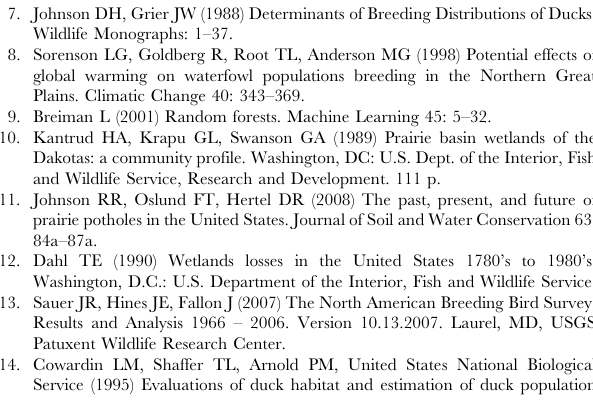
Figure S1 Distribution of grassland and palustrine wetlands on the U.S. Prairie Pothole Region landscape. Darker shades represent greater coverage of grassland (versus cropland) and greater areal coverage of wetlands (log transformed). Figure S2 Map of species distributions for baseline and two future climate projections. Brown indicates areas where the species is predicted to occur and green represents areas where the species is not predicted to occur. Figure S3 Map of species distributions for baseline and two future climate projections. Brown indicates areas where the species is predicted to occur and green represents areas where the species is not predicted to occur. Figure S4 Map of species distributions for baseline and two future climate projections. Brown indicates areas where the species is predicted to occur and green represents areas where the species is not predicted to occur. Figure S5 Map of species distributions for baseline and two future climate projections . Brown indicates areas where the species is predicted to occur and green represents areas where the species is not predicted to occur. Figure S6 Map of species distributions for baseline and two future climate projections. Brown indicates areas where the species is predicted to occur and green represents areas where the species is not predicted to occur.